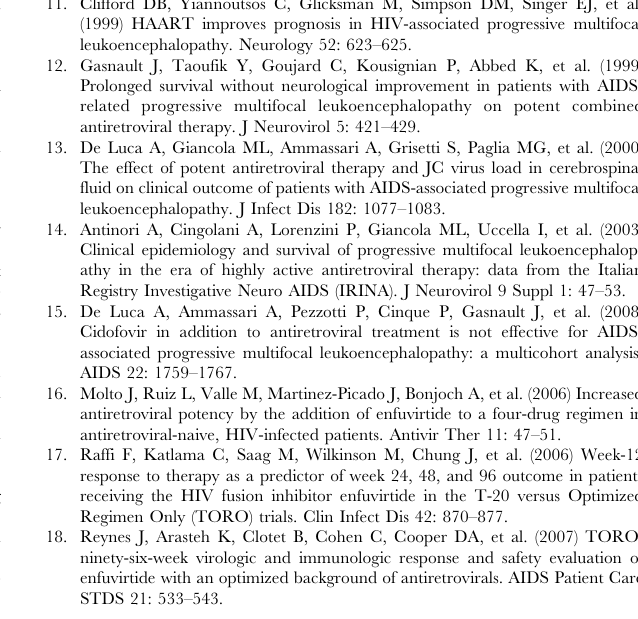
Protocol S1 Short version of the protocol of the ANRS 125 Trial ‘‘Early Intensification of Antiretroviral Therapy Including Enfuvirtide in HIV-1-Related Progressive Multifocal Leucoen-